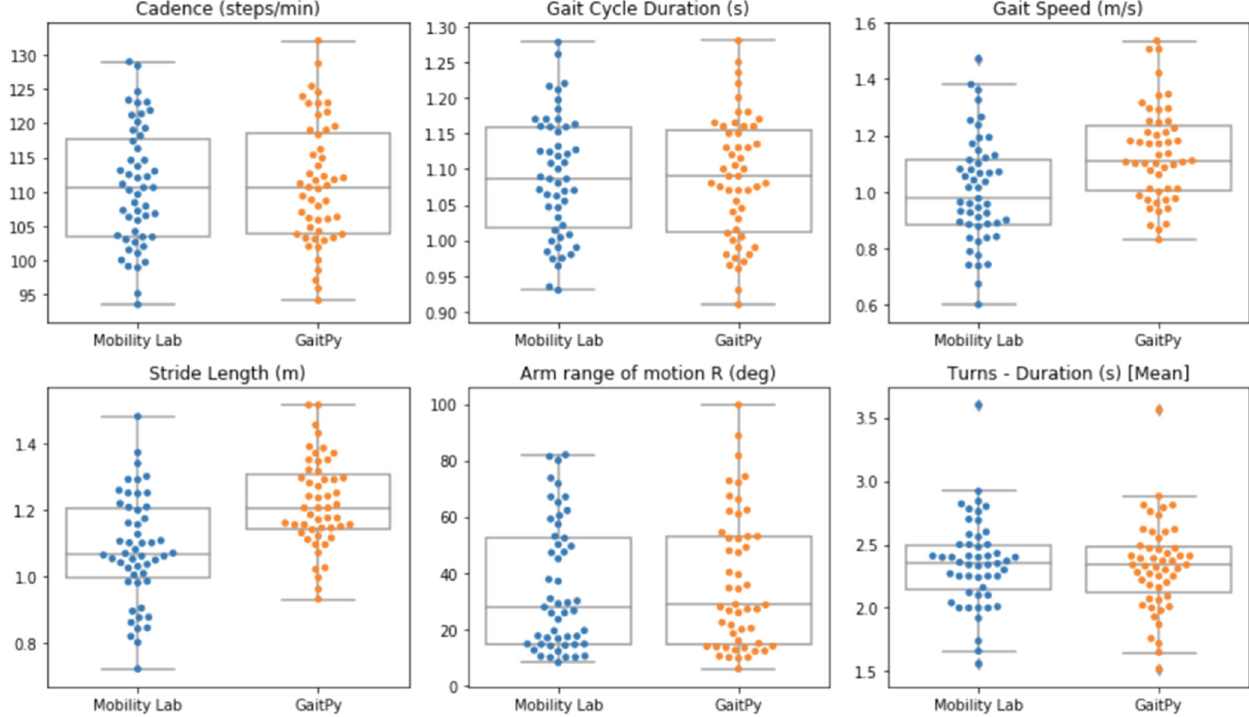
Fig. 3 Gait Feature Variability. Variability of selected gait features calculated on the same measurements performed using Opal and using GaitPy and Mobility Lab correspondingly. The solid line represents the median value; the box limits show the interquartile range (IQR) from the fi rst (Q1) to third (Q3) quartiles; the whiskers extend to the furthest data point within Q1 – 1.5*IQR (bottom) and Q3 + 1.5*IQR